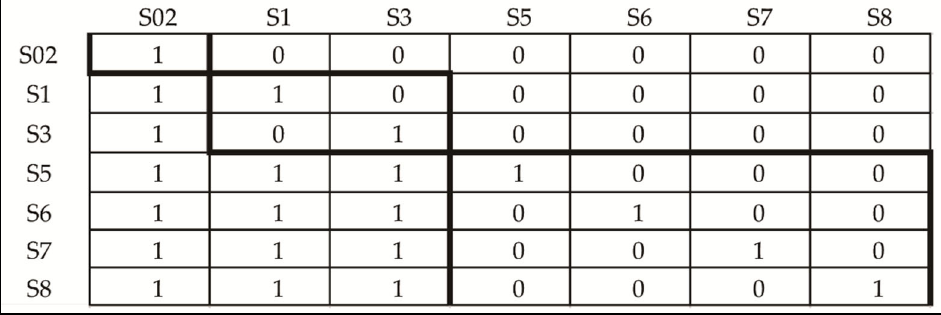
Figure 6. Reachability matrixes after ranking of quantitative decision making.